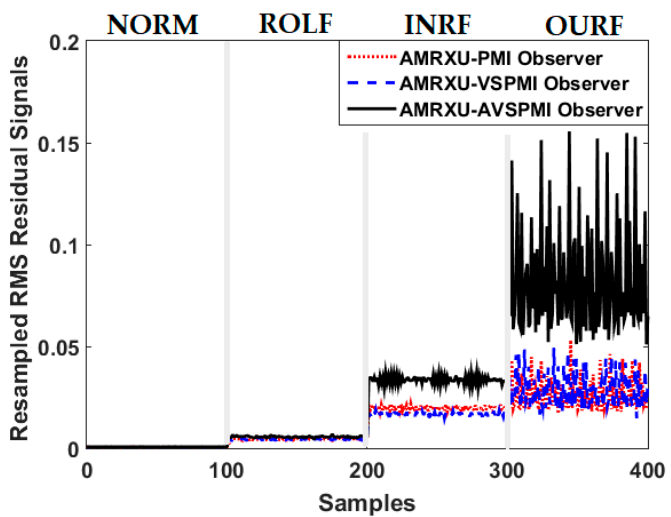
Figure 7. Resampled RMS residual signals under normal and abnormal conditions using AMRXU- PMI, AMRXU-VSPMI, and the proposed AMRXU-AVSPMI observers.